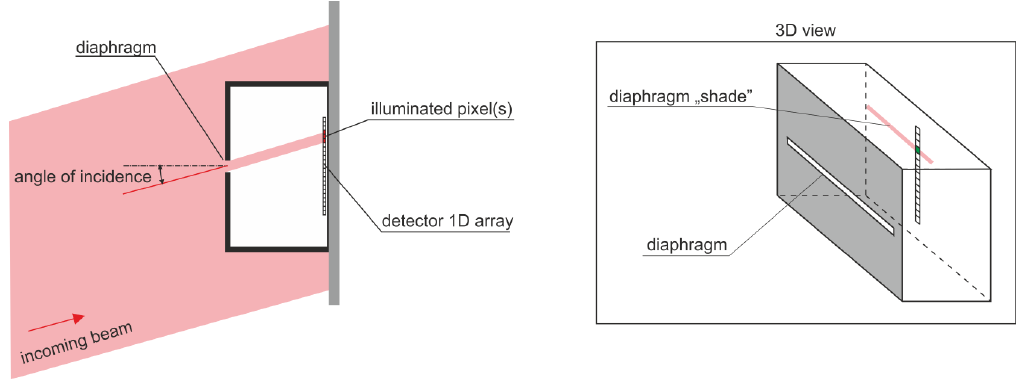
Figure 4. Idea of the “shade method”, commonly applied in most high-resolution AOI sensors.